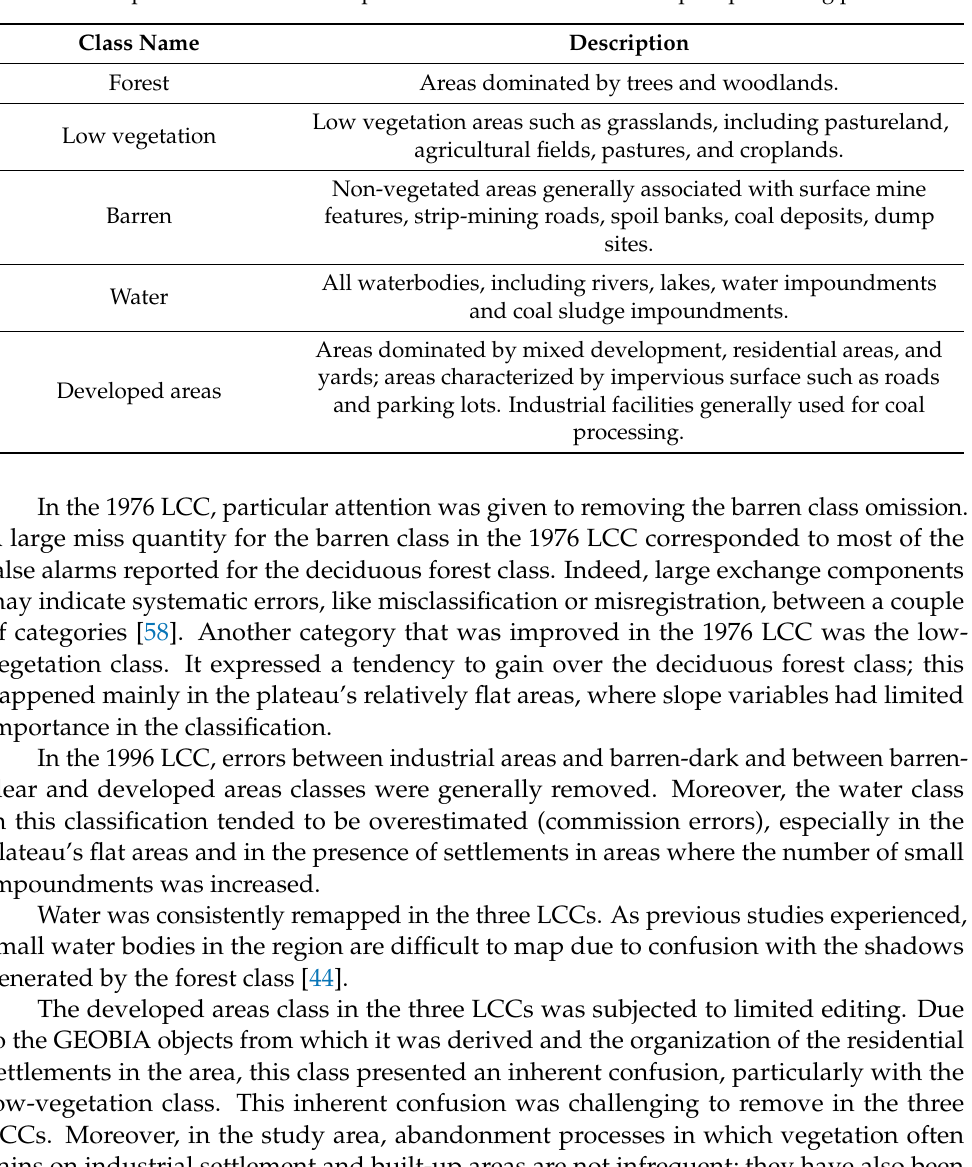
Table 7. Description of the classes adopted in the three LCCs after the post-processing